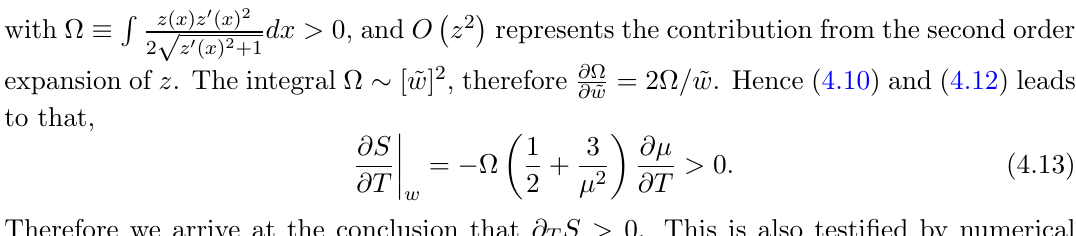
Figure 10 . HEE behavior with temperature at di(cid:11)erent